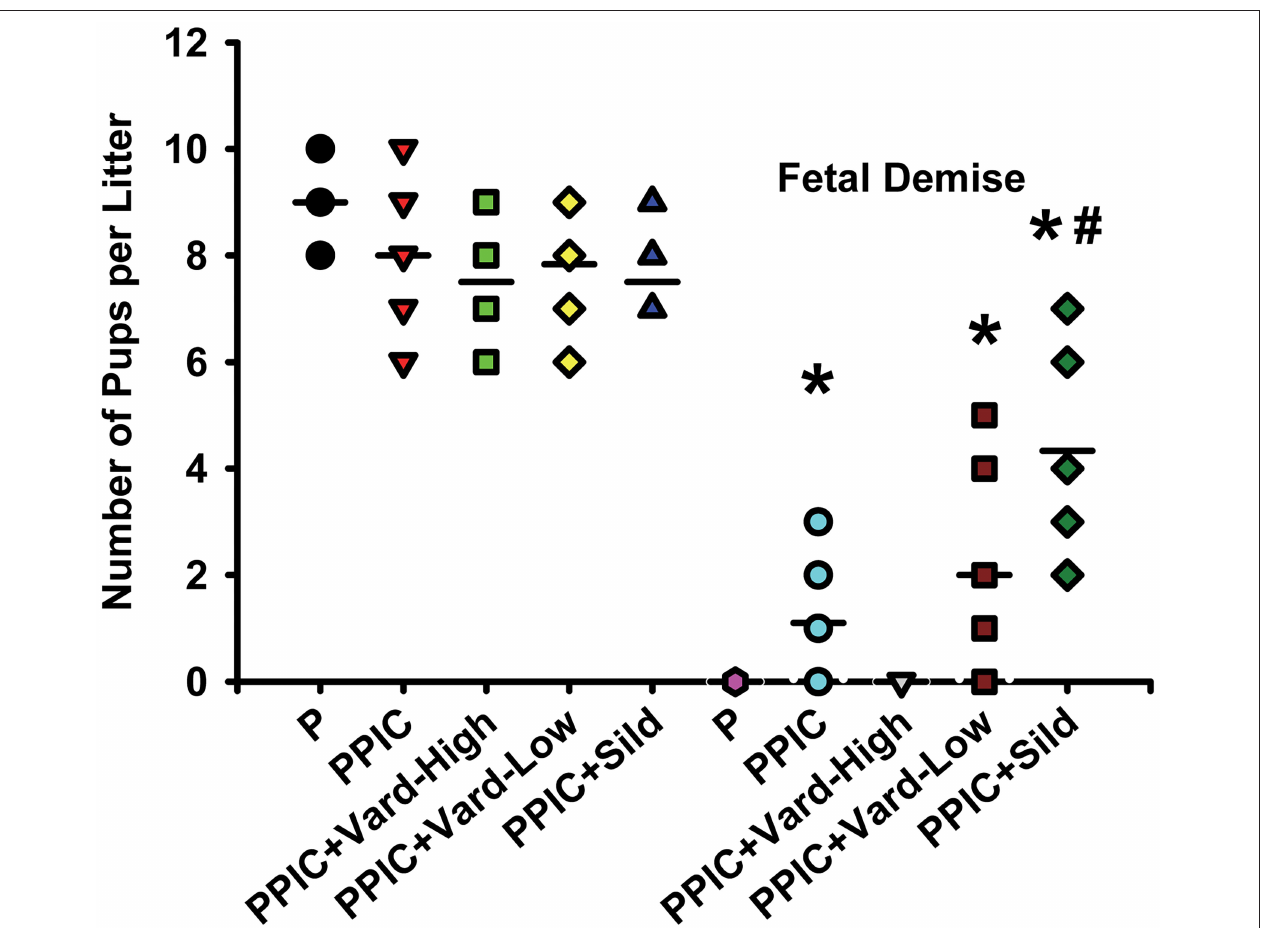
FIGURE 4 | Number of pups per litter as well as number of pups undergoing fetal demise per litter of control pregnant (P) mice ( n = 10), P mice treated with the TLR3 agonist and viral mimetic poly I:C (PPIC) ( n = 10), PPIC mice treated with a high dose ( n = 6) and low dose ( n = 6) of vardenafil (Vard), and PPIC mice treated with sildenafil (Sild) ( n = 6). * p < 0.05 by ANOVA compared to P mice, # p < 0.05 by ANOVA compared to PPIC